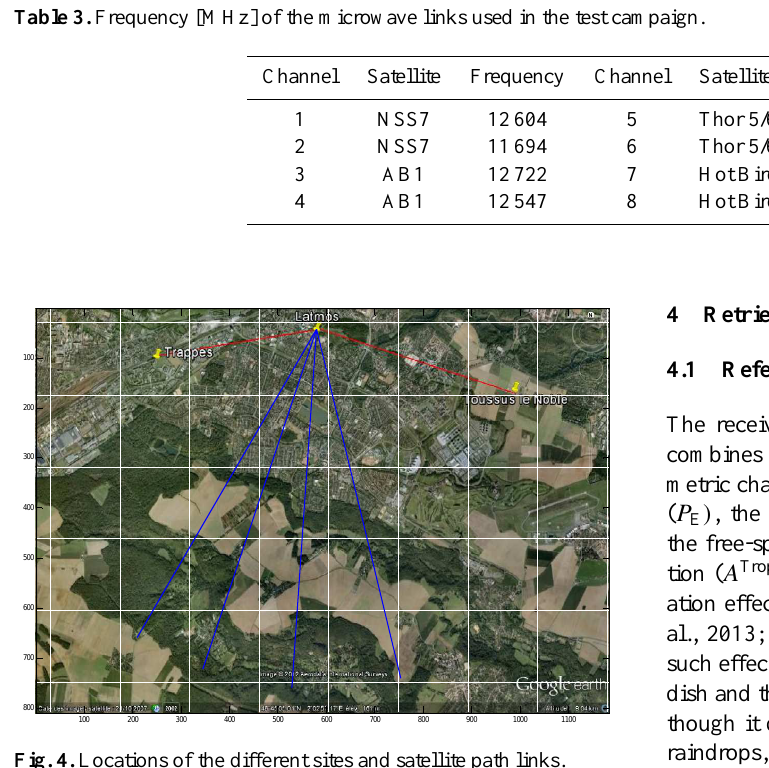
Table 3. Frequency [MHz] of the microwave links used in the test campaign.